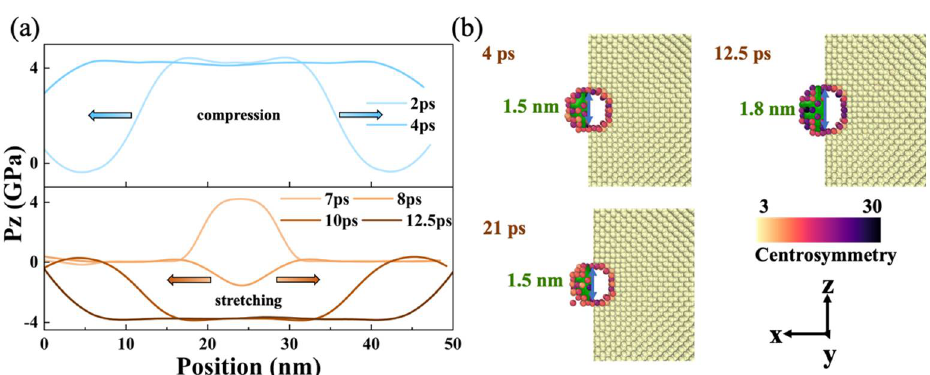
Figure 2. ( a ) Evolution of longitudinal stress profile at v 0 = 0.25 km/s, where Pz is the stress component along the z direction. Compression and stretching processes are represented by different colors. At the beginning of the impact (2, 4 ps), compression occurs, and the pressure is positive. After 7 ps, it changes to the tensile process, and the stress is negative. ( b ) Microscopic views of void evolution changes at 4, 12.5, and 21 ps. Left: atoms with centrosymmetry values of less than 8 were deleted. Right: the plane shown here was 1 nm thick at the center of the void.